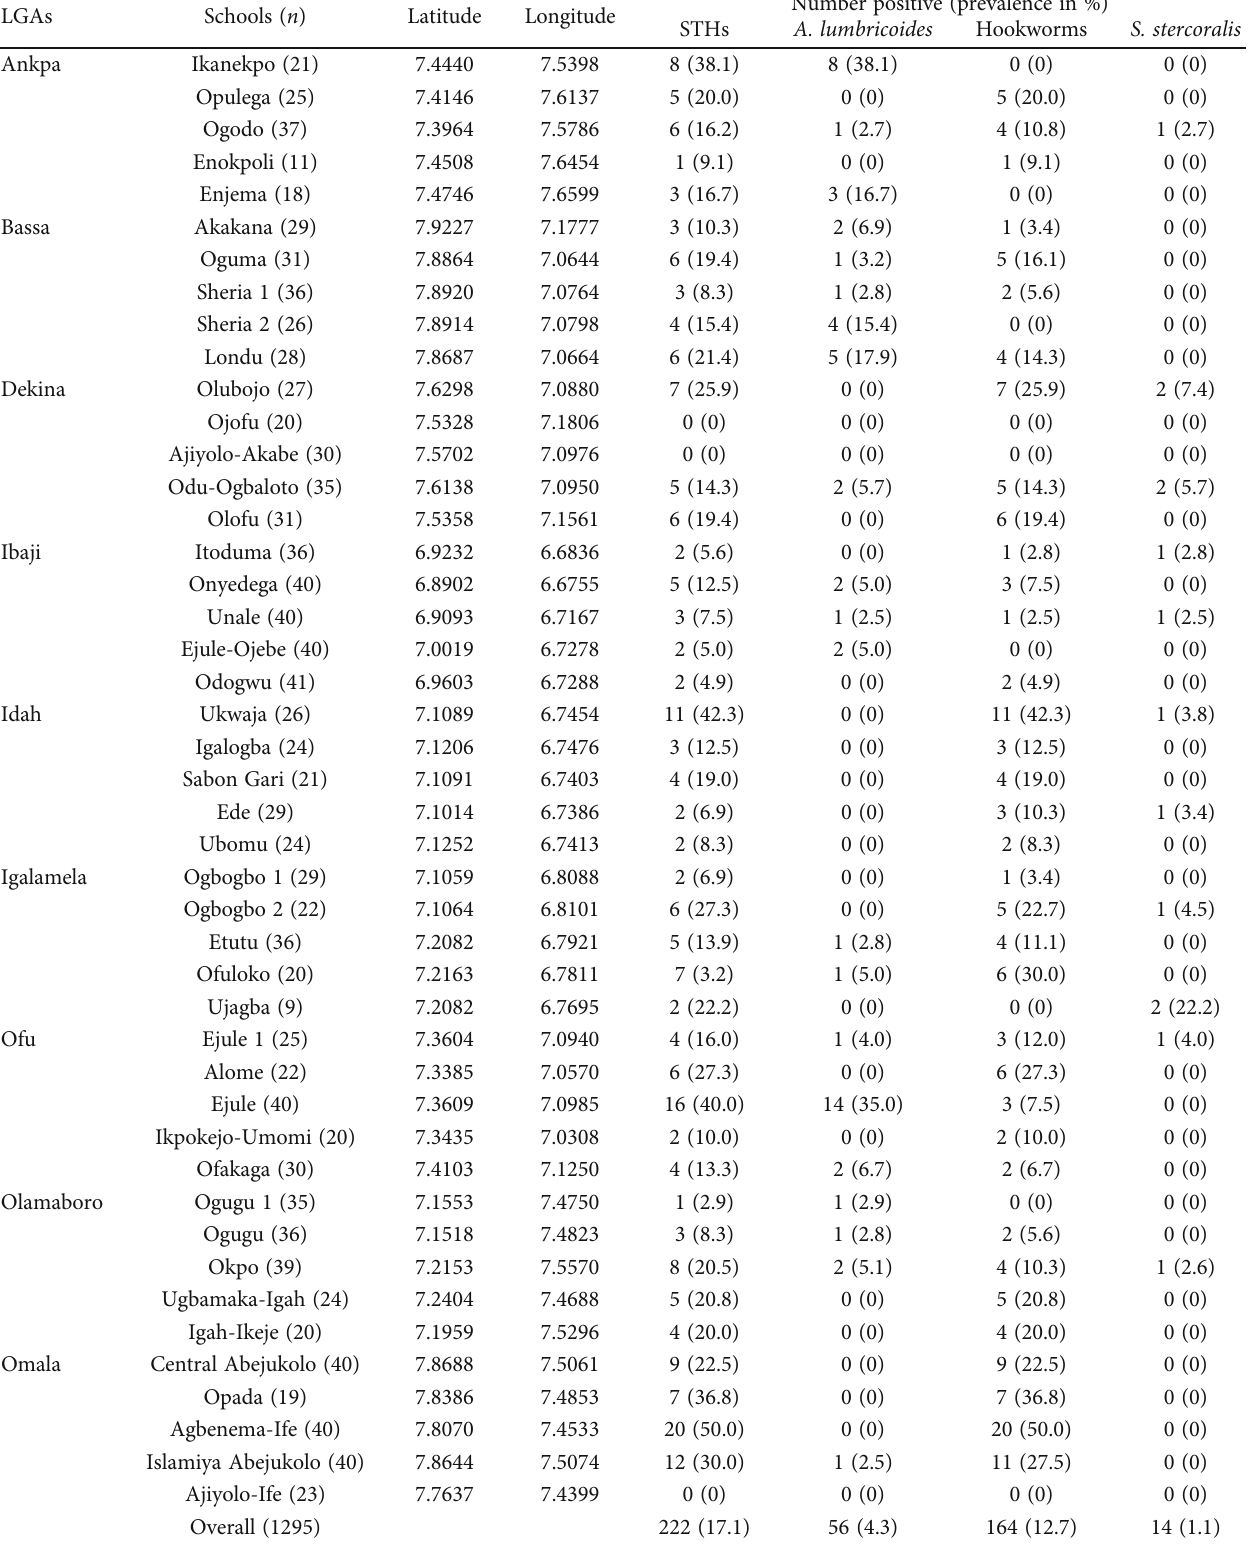
Table 1: Prevalence of STHs in rural primary schools of Kogi East, Nigeria, during baseline survey.